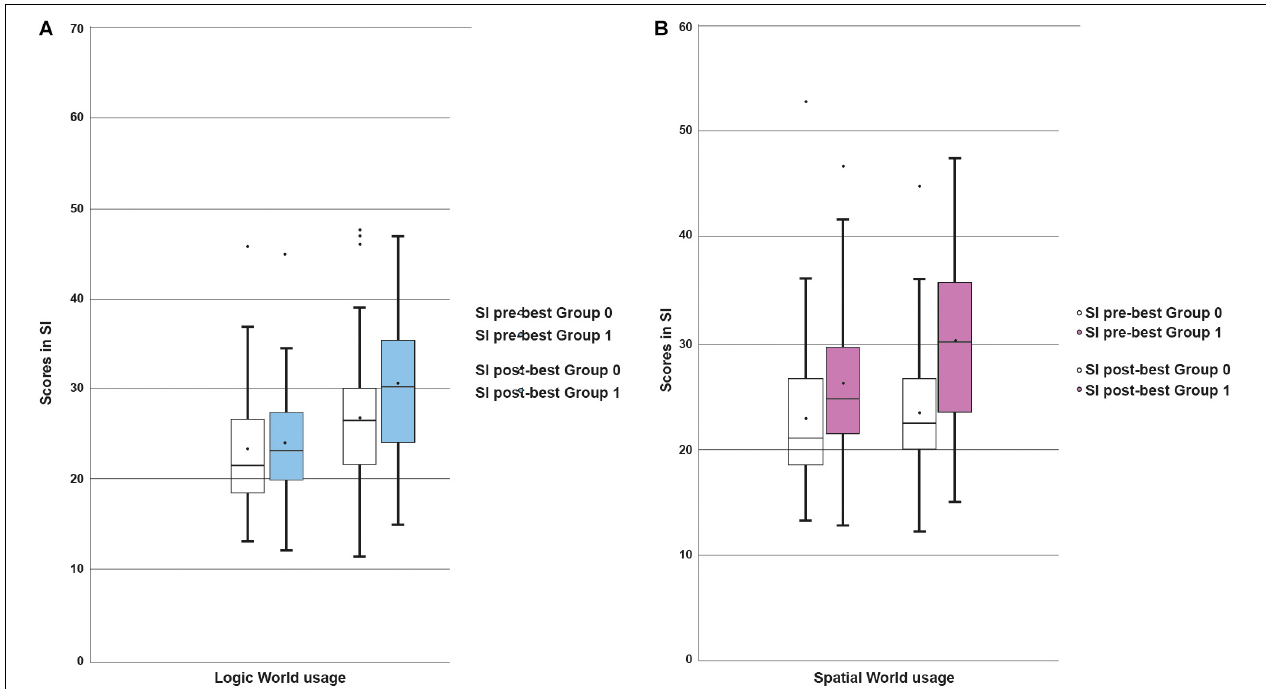
FIGURE 6 | Graphics of the differences between group 0 (less use) and group 1 (more use) to scores taken from S1: (A) with the use of Logic activities; (B) with the use of Spatial activities.